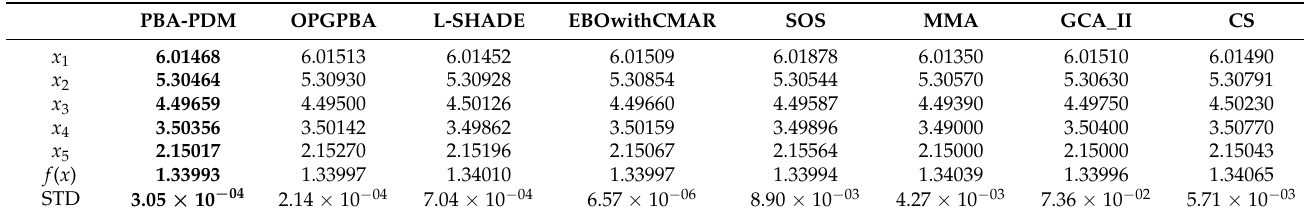
Table 19. The comparison of PBA-PDM with other optimizers in Cantilever Beam